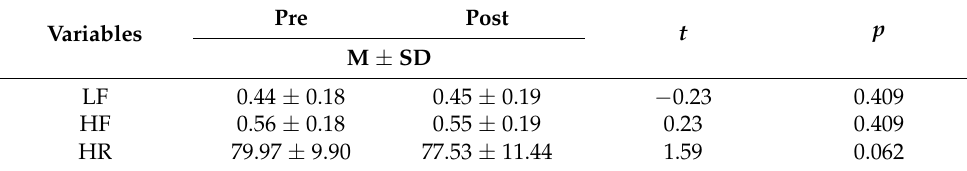
Table 5. Differences in Heart Rate Variability (HRV) ( n = 28).